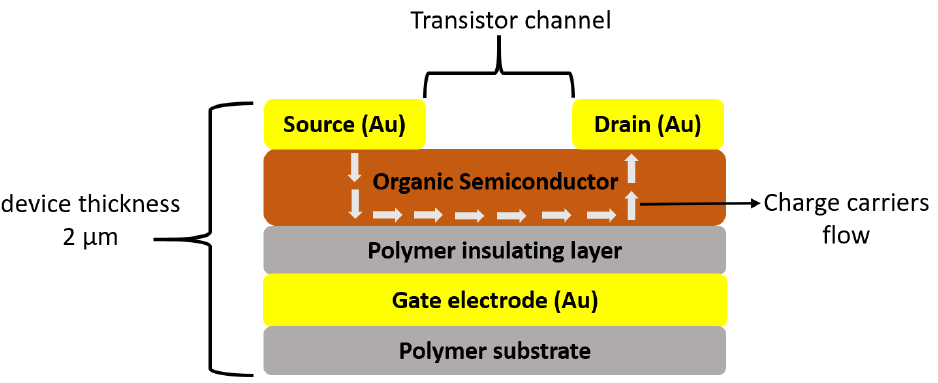
Figure 1. Scheme of flexible organic transistor in bottom gate–top contact electrode configuration.